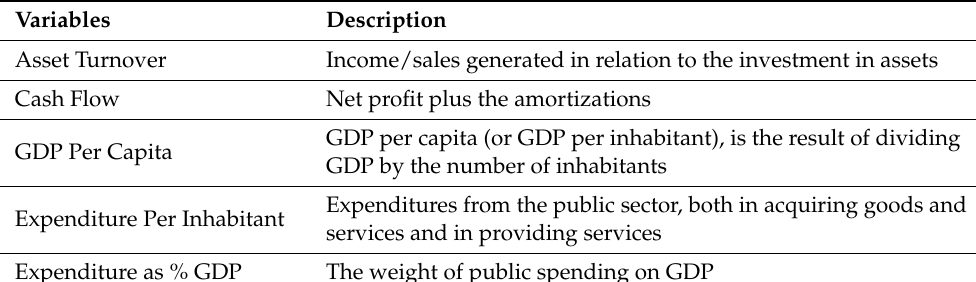
Table 1. Description of